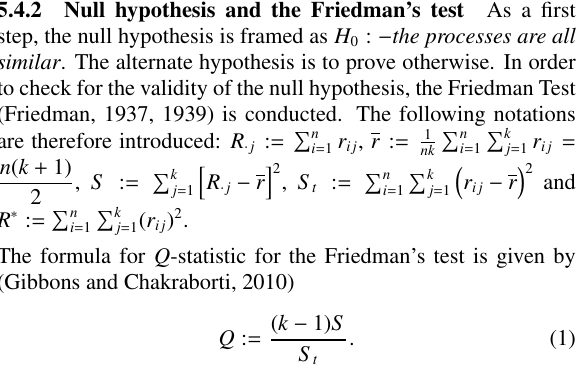
Table 4: Ranks for each of the n